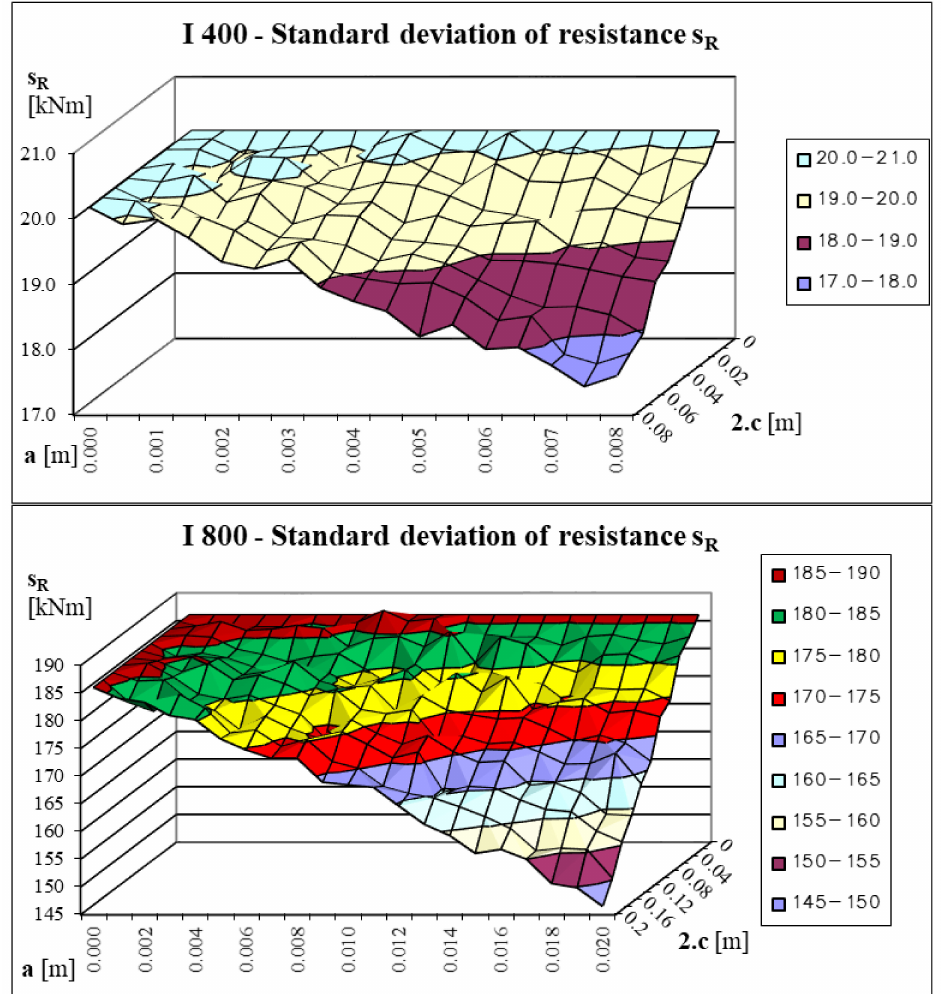
Figure 8. Influence of crack size on resistance standard deviation s R